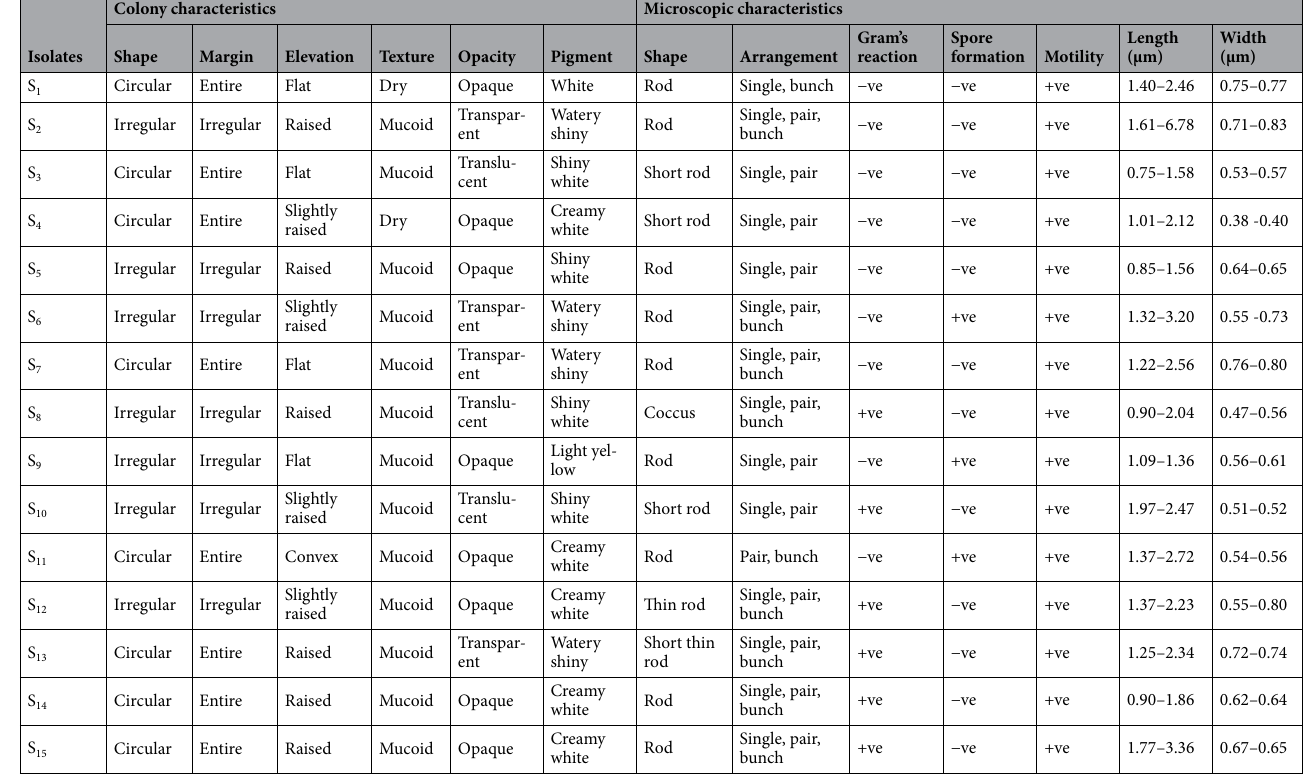
Table 2. Colony and microscopic characteristics of halophilic bacterial